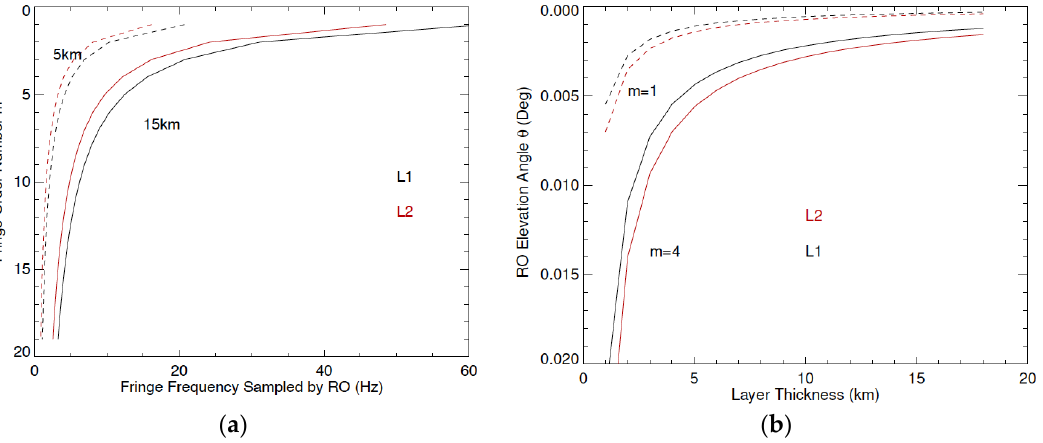
Figure A7. RO grazing angle interference patterns predicted from a single-layer thin-film model: ( a ) Fringe number m as a function of RO sampling frequency; ( b ) RO elevation angle q as a function of